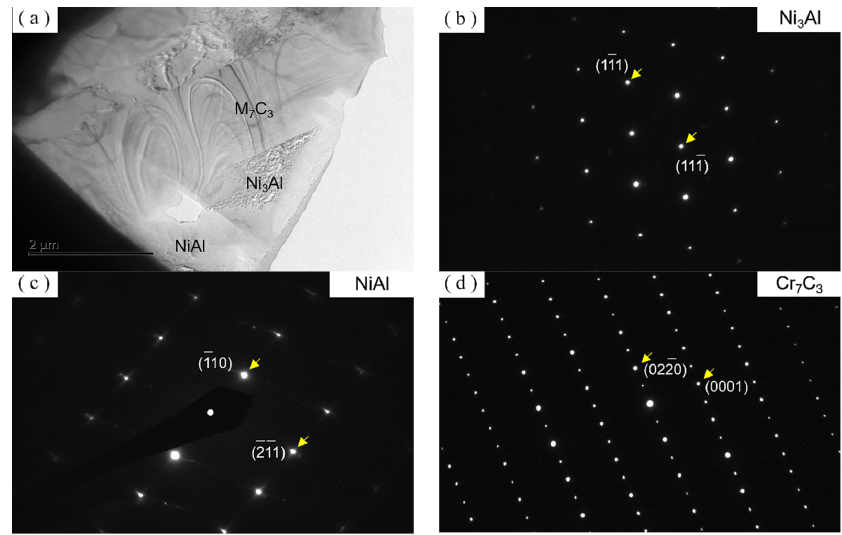
Figure 9. TEM results of the alloyed powder cladding layer. ( a ) TEM image of Ni 3 Al, NiAl, and Cr 7 C 3 ; ( b – d ) electron diffraction patterns of Ni 3 Al, NiAl, and Cr 7 C 3 , respectively.